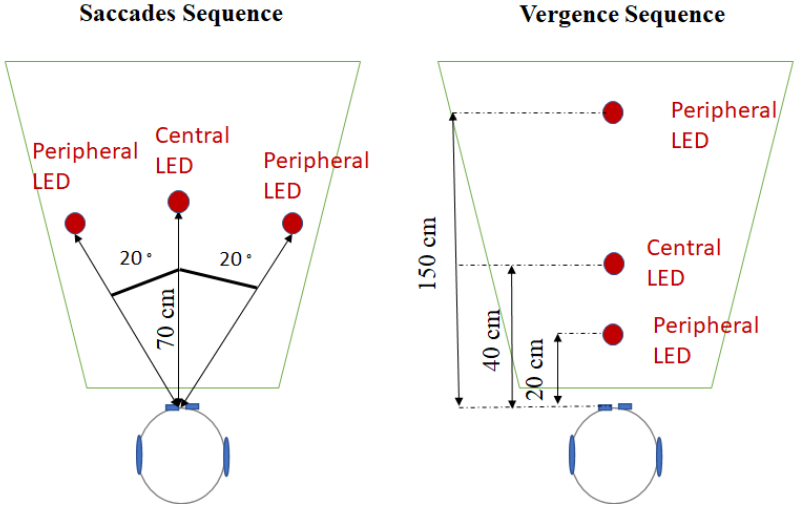
Figure 1. Top-view of the position of the LEDs for the saccades test ( left ) and for the vergence test ( right ).